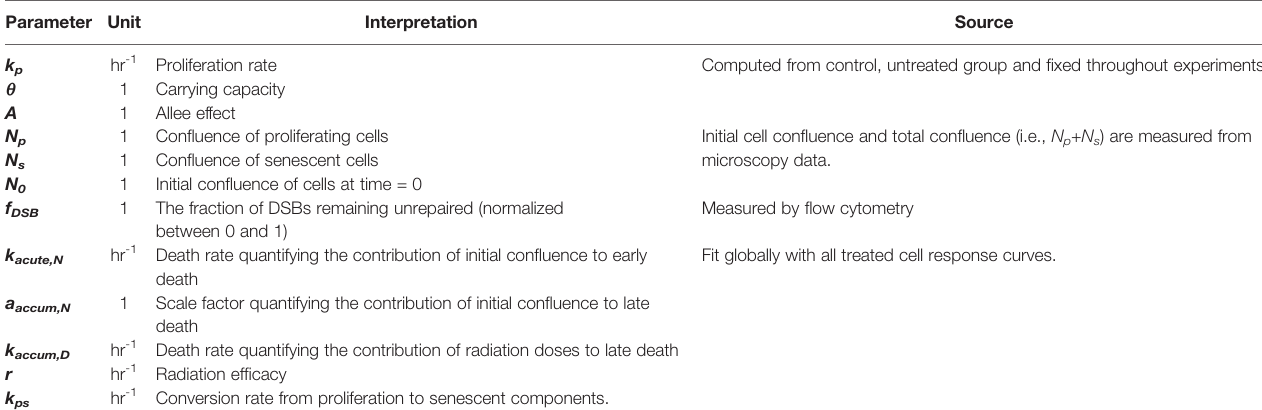
TABLE 1 | Model parameters and